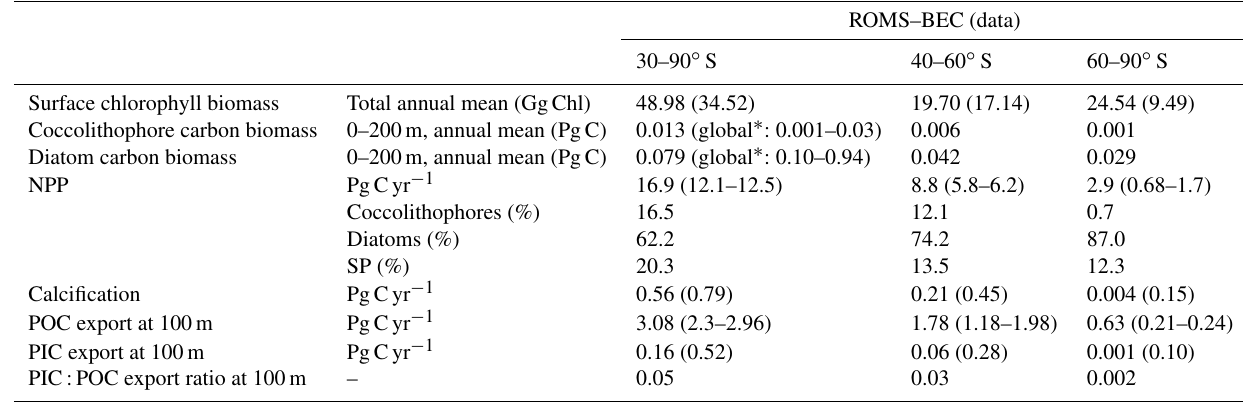
Table 3. Comparison of ROMS–BEC-based phytoplankton biomass, production, calcification, and export estimates with available observa- tions (given in parentheses). See Appendix Table A1 for data